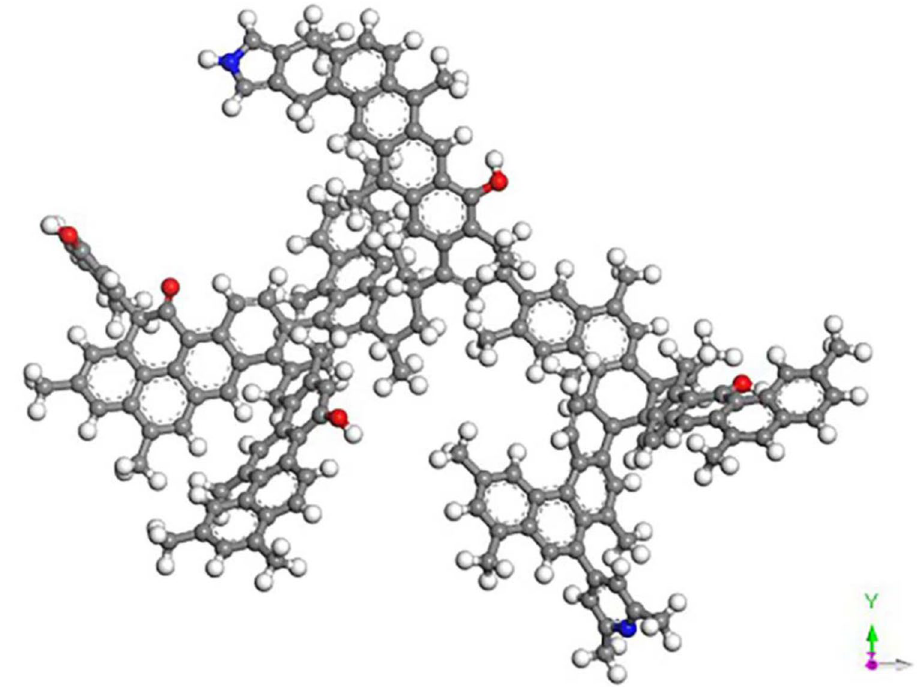
Figure 1. Molecular model of Dongqu